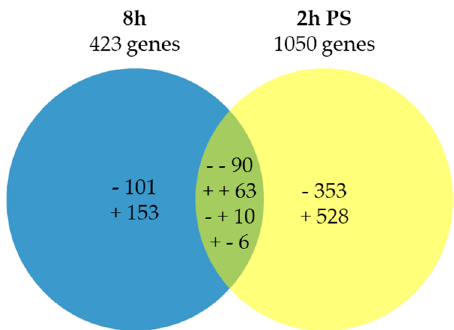
Figure 1. Venn diagram of the number of transcripts (both identified and unknown) that were up- or down-regulated by cold stress based on microarray analyses. The « + » and « - » indicate up- and down-regulated transcripts, respectively. In total, 423 and 1050 stress-inducible genes were identified at 8 h and 2 h PS, respectively. 101: unique down-regulated transcripts at 8 h; 353: unique down-regulated at 2 h PS; 153: unique up-regulated transcripts at 8 h; 528: unique up-regulated transcripts at 2 h PS; 90: commonly down-regulated transcripts at both time; 63: commonly up-regulated transcripts at both time; 10: down-regulated at 8 h but up-regulated at 2 h PS; 6: up-regulated at 8 h but down-regulated at 2 h PS.